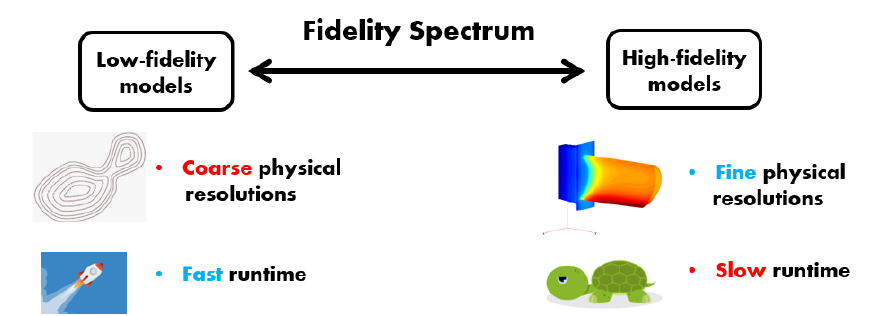
Figure 1. Multi-fidelity, from low-fidelity to high-fidelity models